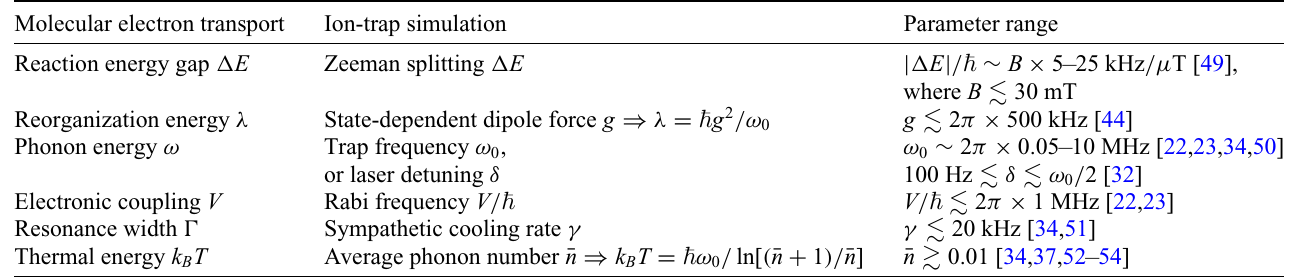
TABLE I. The correspondence between the characteristic parameters of electron transfer (left) and their counterparts in trapped-ion simulations (center), together with typical experimental values in ion-trap platforms (right). The notation in the left column is adopted from Ref.